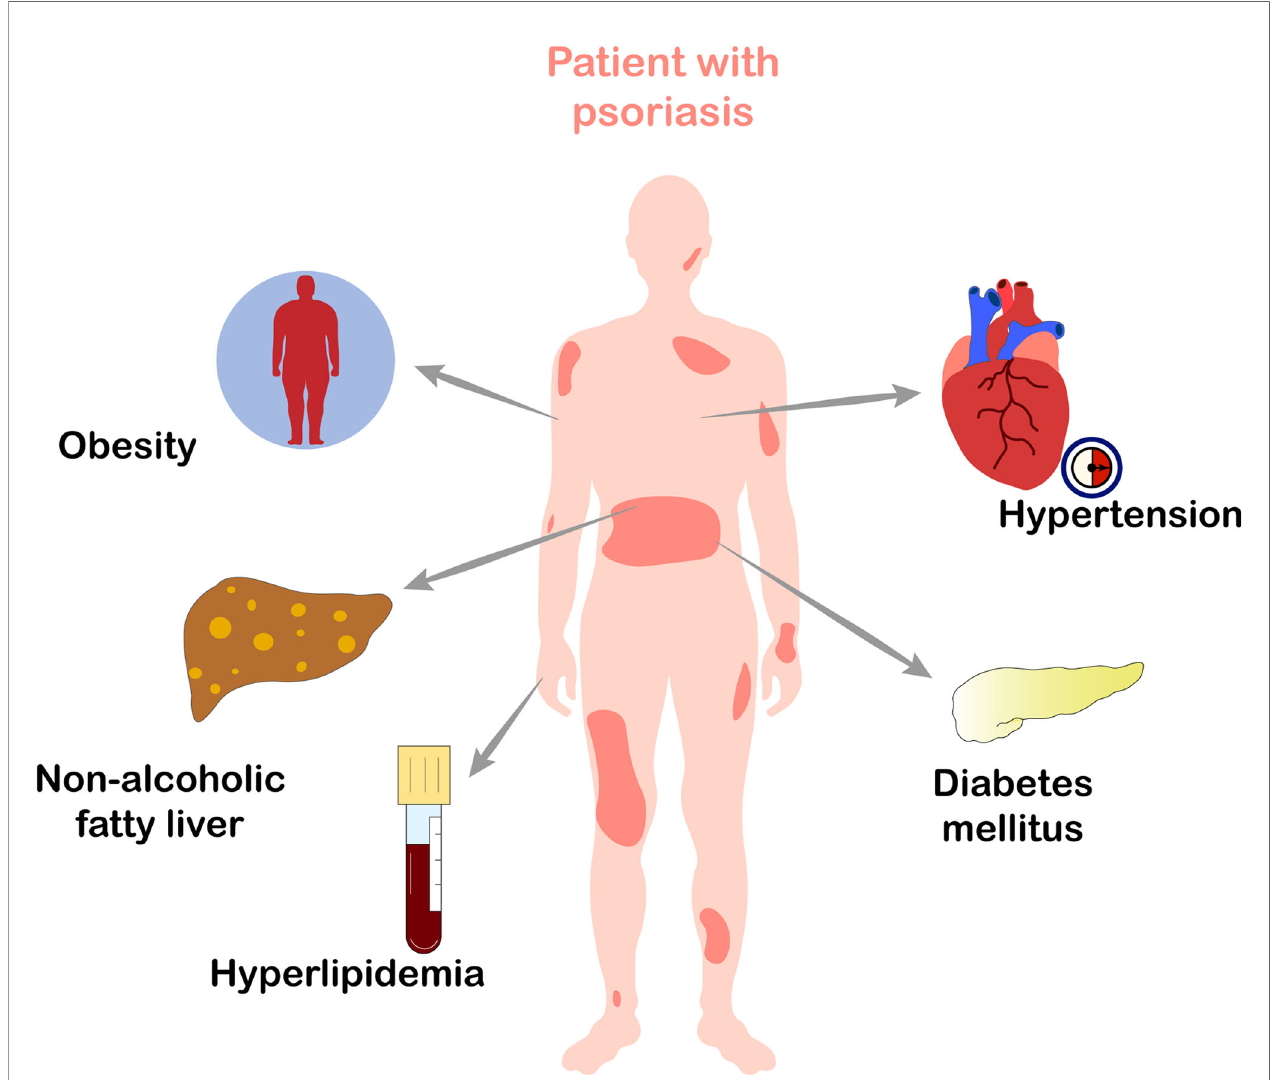
FIGURE 1 | Metabolic diseases which frequently occur in patients with psoriasis. Psoriasis is often associated with obesity, hypertension, diabetes mellitus, hyperlipidemia, and obesity-associated non-alcoholic fatty liver disease, all of which belong to metabolic